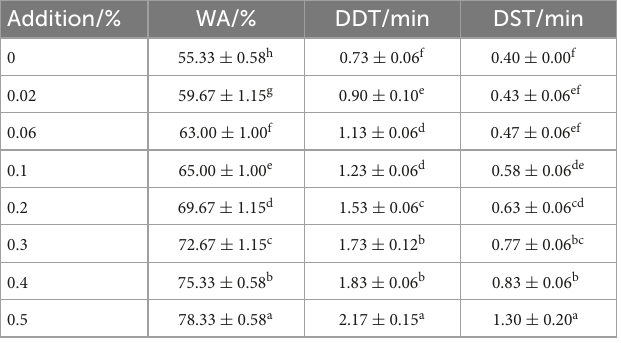
TABLE 2 Effect of sodium bicarbonate on the farinograph properties of rice flour. Addition/%